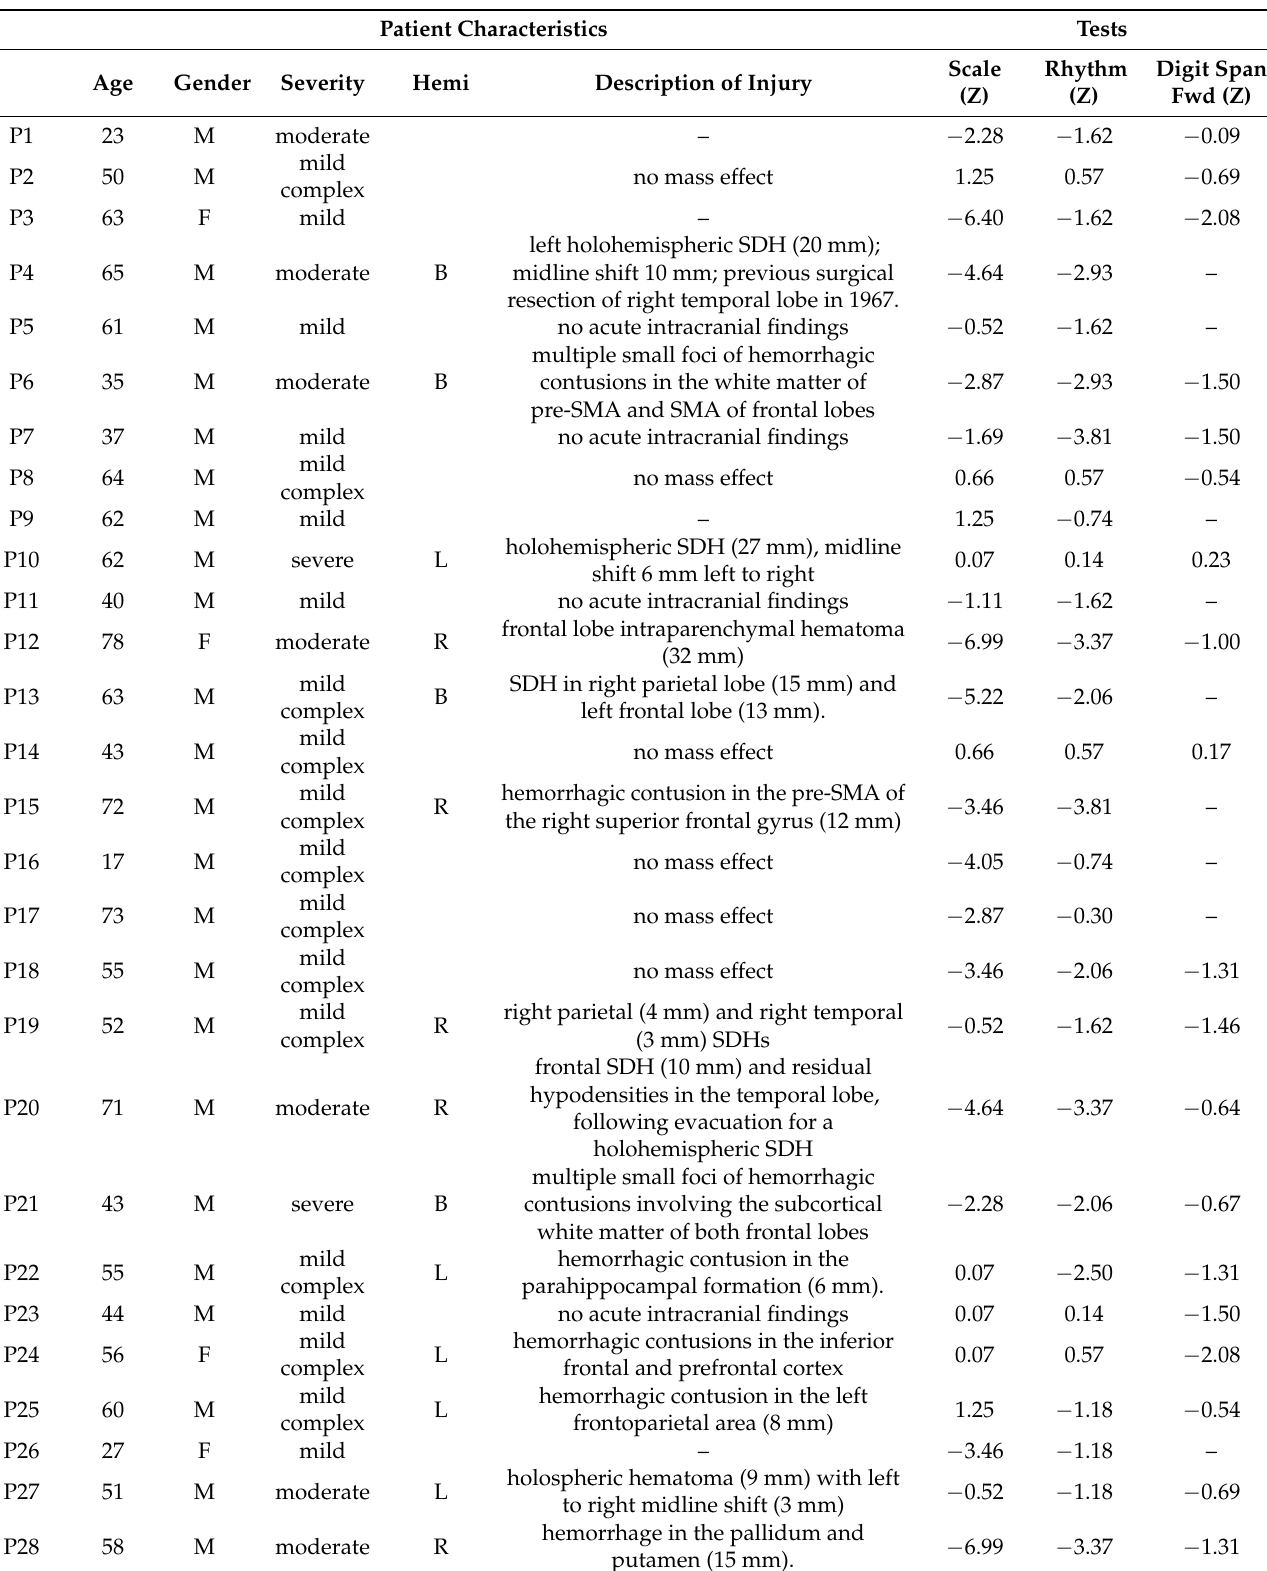
Table 2. Individual patient characteristics, performance on the Scale and Rhythm tests of the MBEA, and the Digit Span Forward test of the